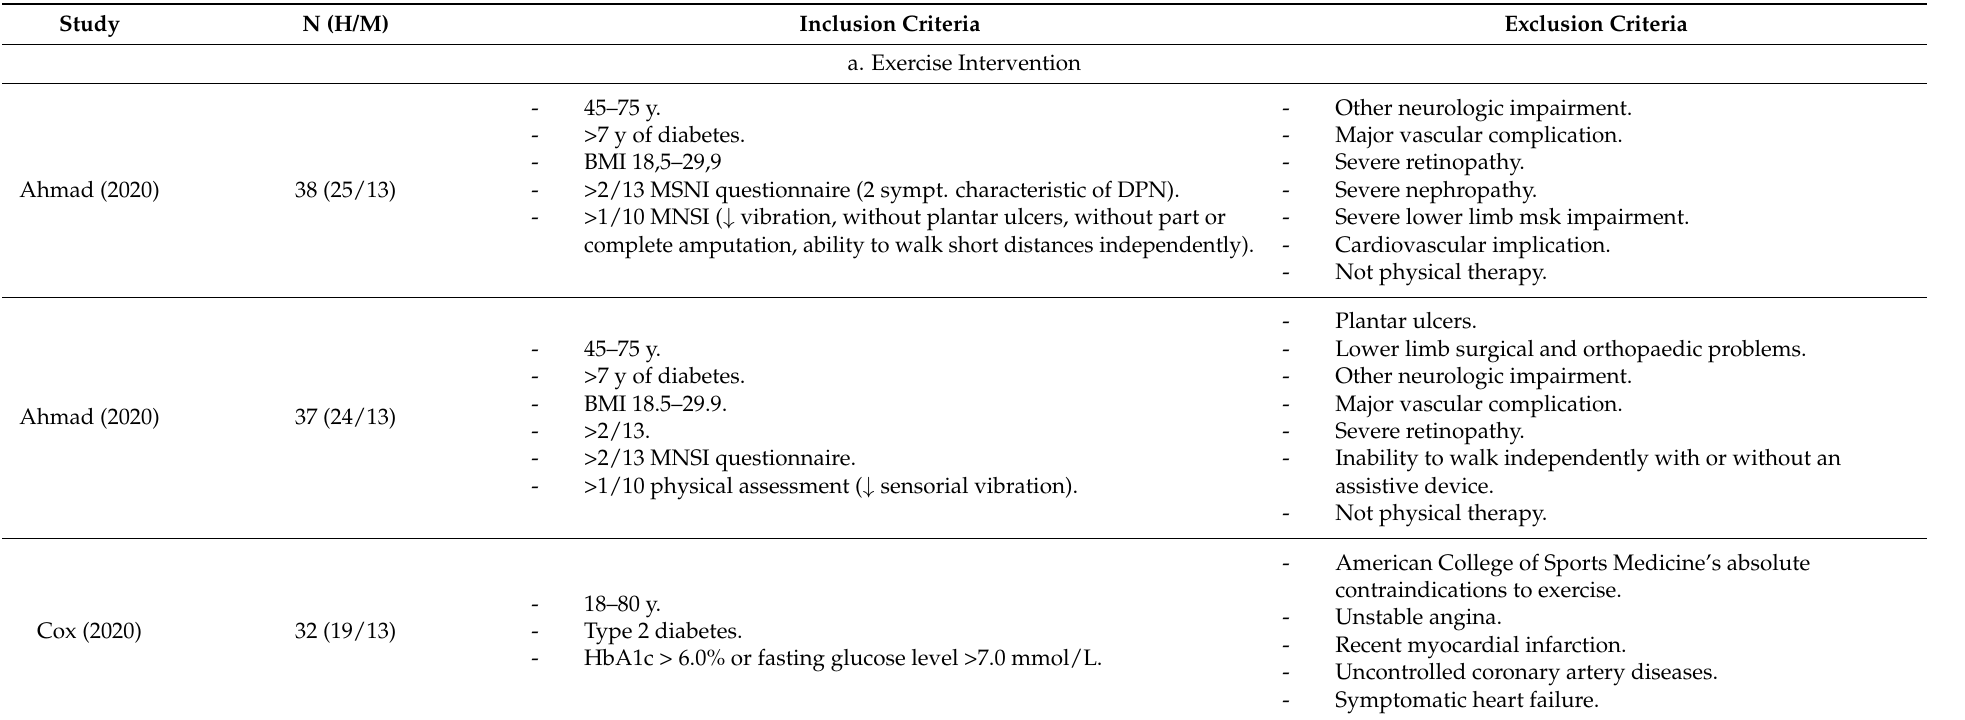
Table 2. Selection criteria of the